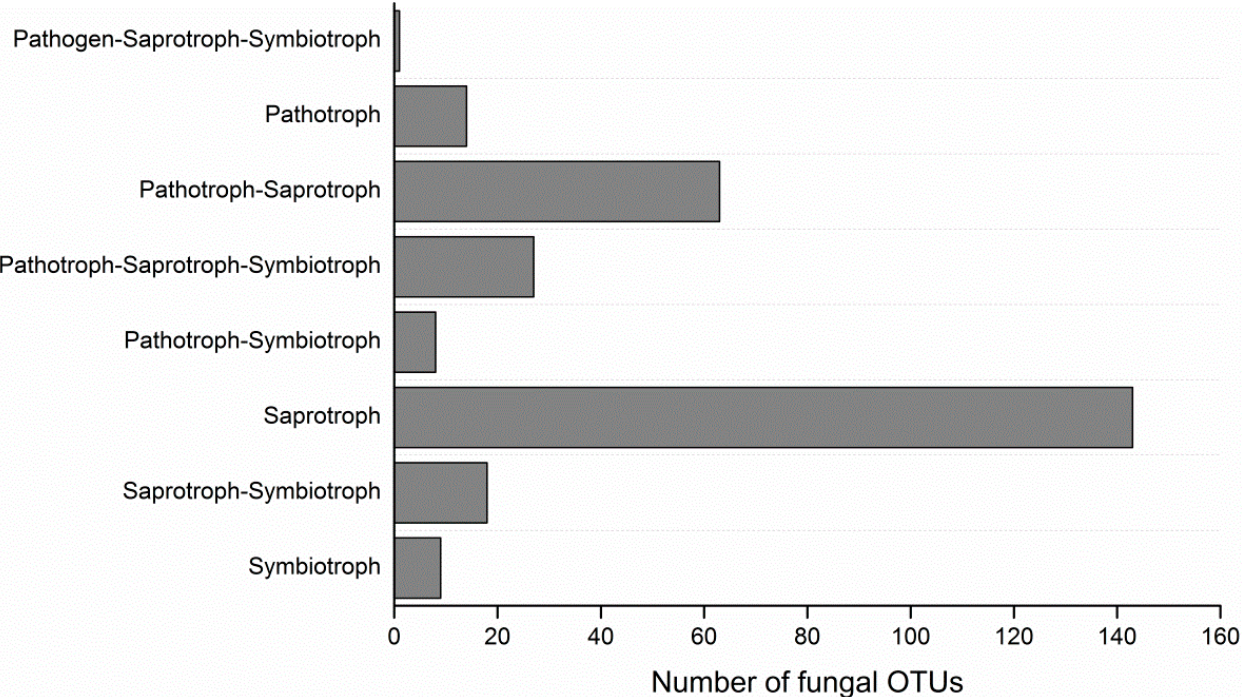
Figure 1. Frequency distribution displaying the number of operational taxonomic units (OTUs) belonging to the different trophic guilds identi fi ed in the roots of Bletilla .